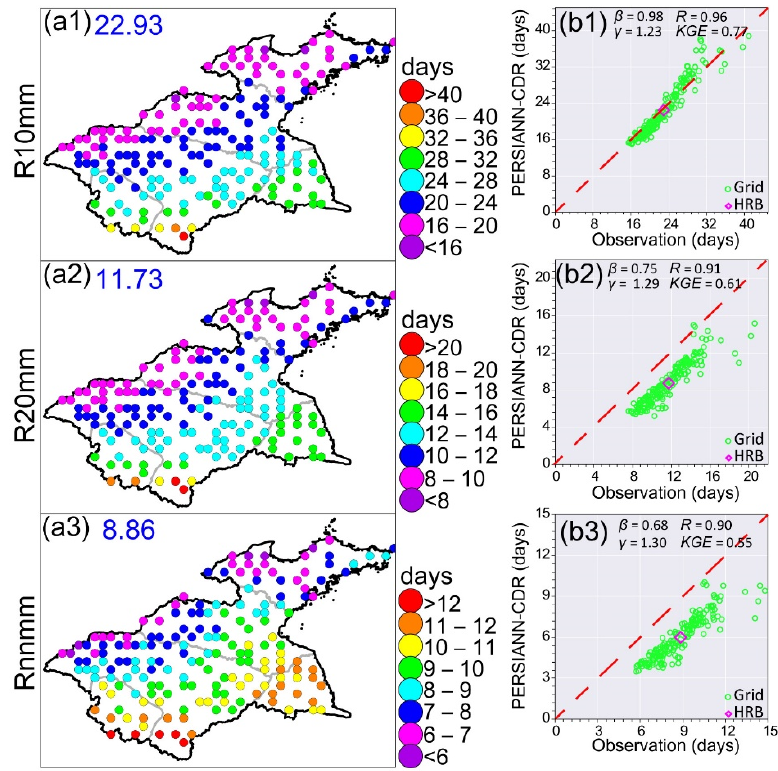
Figure 8. Spatial patterns of multi-year annual means of observational frequency-based indices and the scatterplots between observation and PERSIANN-CDR. a1 – a3 ( b1 – b3 ) are for R10mm, R20mm, and Rnnmm, respectively. In a1 – a3 , the blue numbers represent the HRB mean for a given extreme precipitation index. The red dashed line in b1 – b3 is the 1:1 line.